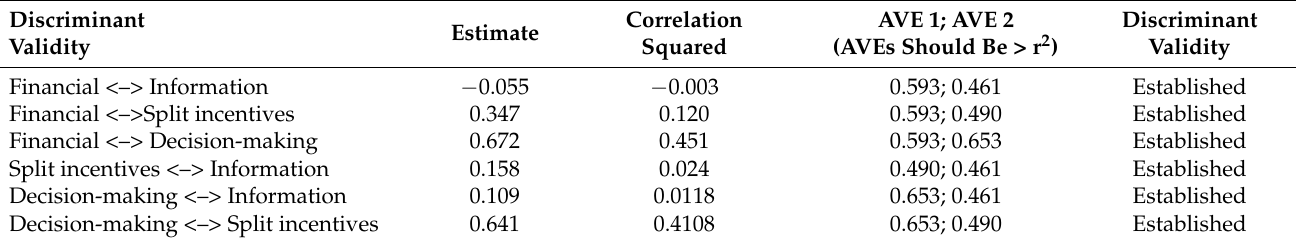
Table 5. Discriminant validity table.